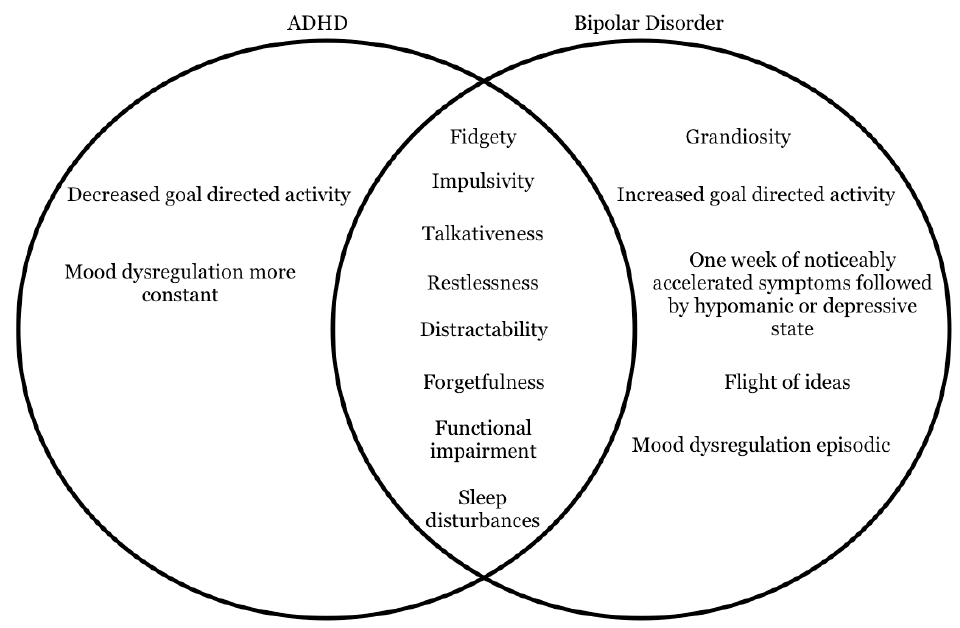
Figure 1. Diagnostic criteria of attention deficit hyperactivity disorder versus bipolar